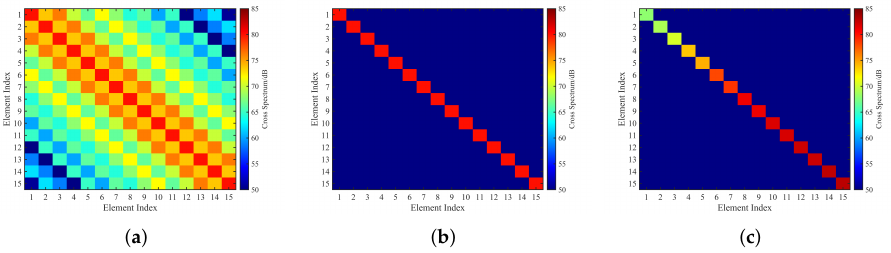
Figure 3. ( a ) The received noise CSM, its ( b ) whitening matrix, and ( c ) diagonalizing matrix under the ideal condition that assumes that the ambient noise CSM is the same as the received noise